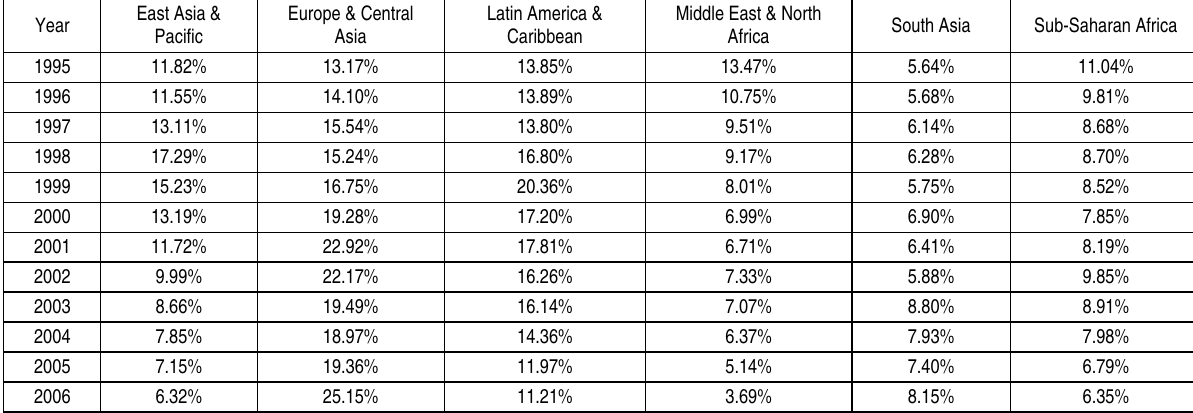
Table 9. Trends in VR external debt to GDP